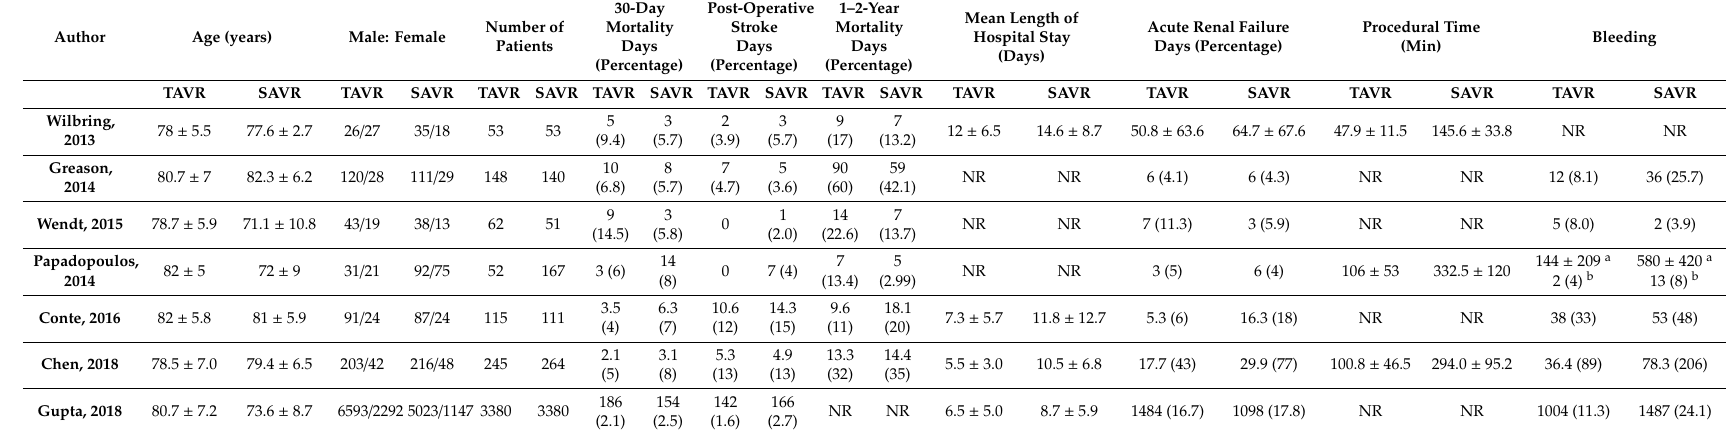
Table 1. Characteristics of involved studies, and outcomes reported in patients who underwent transcatheter versus surgical aortic valve replacement with a history of prior redo coronary artery bypass graft